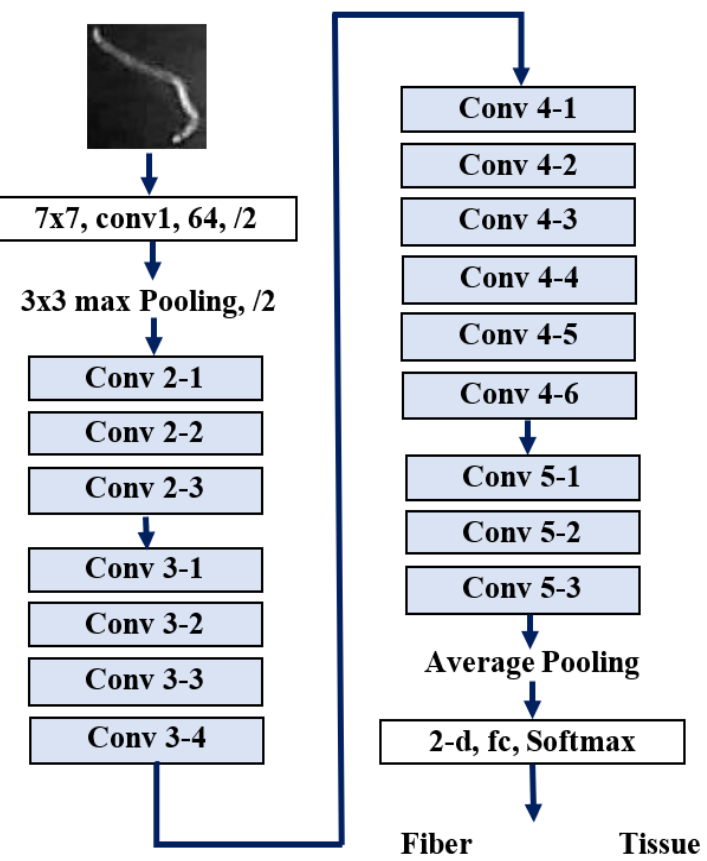
Figure 3. ResNet50 Figure 3. ResNet50 architecture.